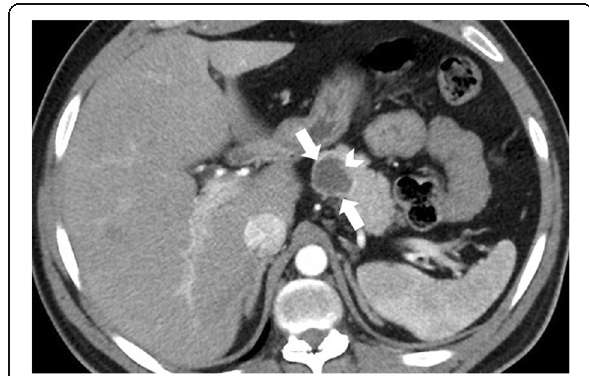
Fig. 25 A 31-year-old male patient with known MEN-1 syndrome underwent CT scanning to detect manifestations of the syndrome. Axial plane post-contrast pancreatic phase CT image shows a predominantly cystic lesion in the pancreatic body (arrows). Focal contrast-enhancing mural wall thickening can also be seen (arrowhead). Histopathological findings revealed cystic NET